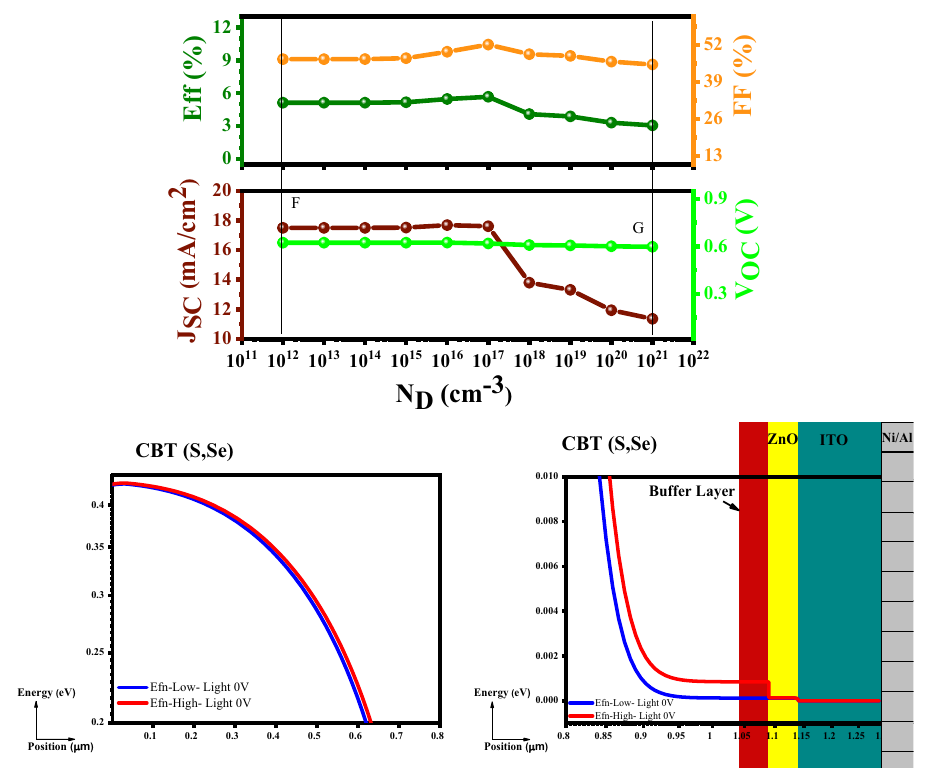
Figure 8. Variation of the solar cell parameters of the CBT (S, Se) solar cells with different N D of In 2 S 3 layer.